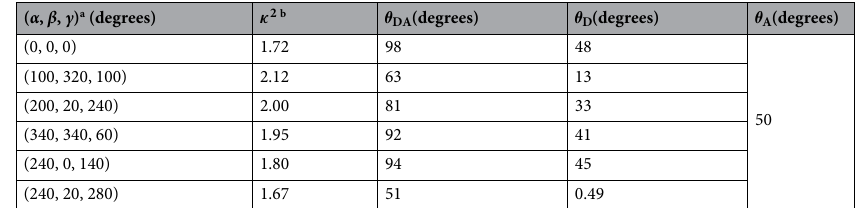
Table 3. Angles of real transition dipole moments between A647 and BChl1 (degrees). a Values of Euler